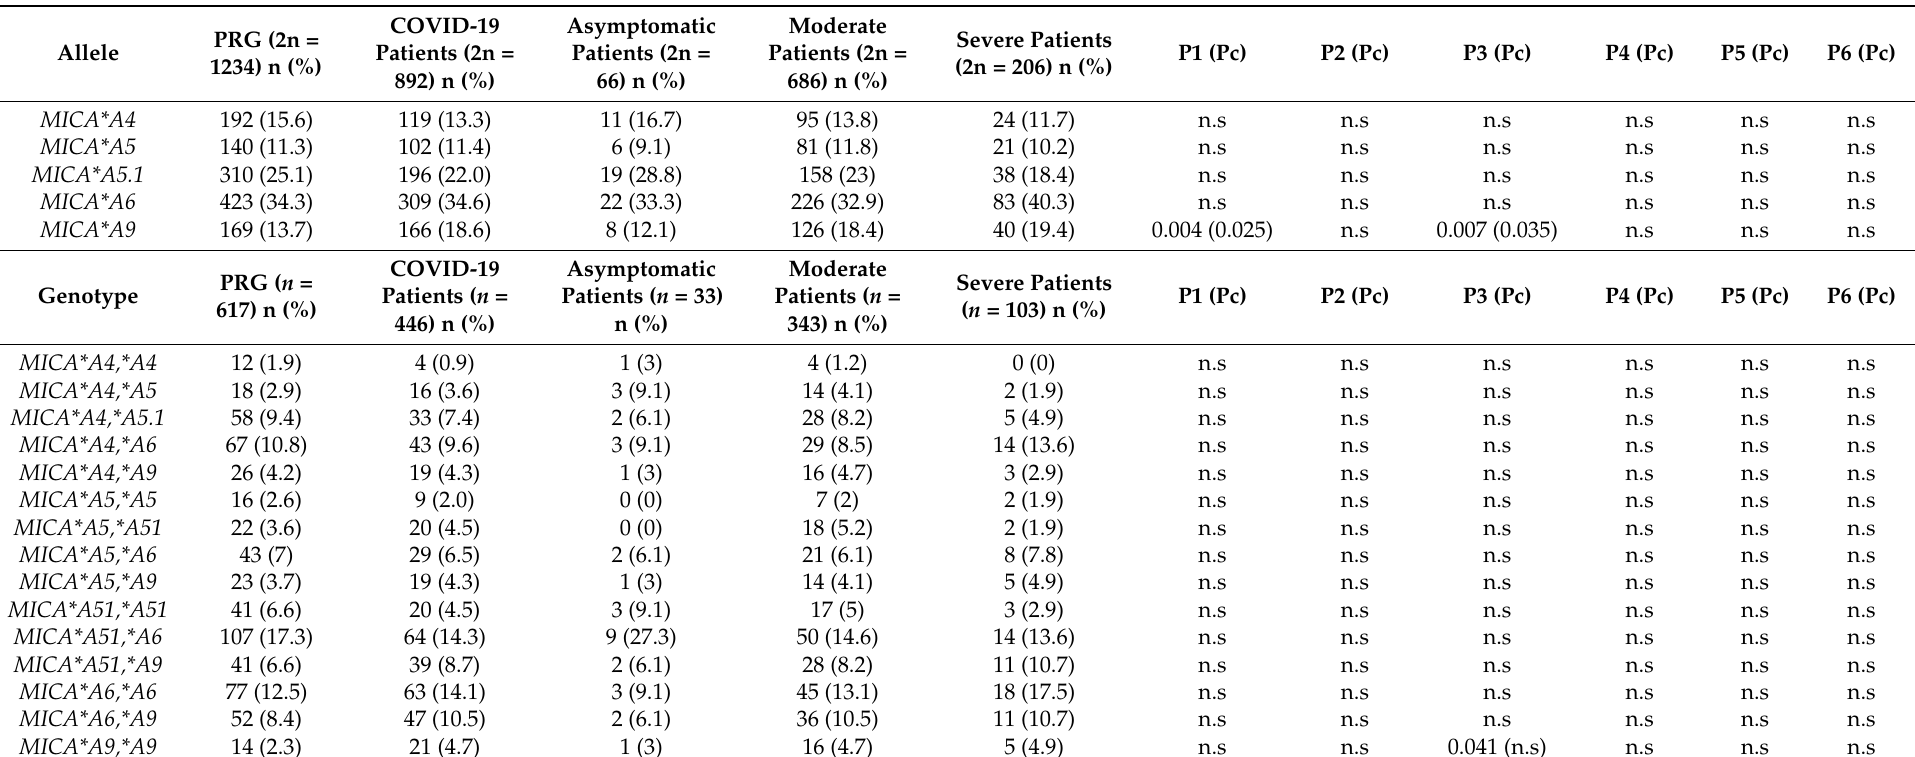
Comparison of allele and genotype frequencies between COVID-19 patients and population reference group (PRG). P1: PRG vs. COVID-19 patients; P2: PRG vs. Asymptomatic Patients; P3: PRG vs. Moderate Patients; P4: PRG vs. Severe Patients; P5: Asymptomatic vs. Moderate Patients; P6: Asymptomatic vs. Severe Patients; Pc = p -value corrected by the Bonferroni test; n.s: not